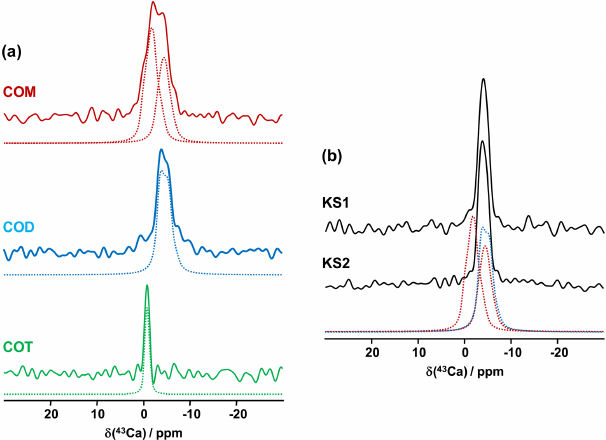
Figure 6. (a) Natural abundance 43 Ca MAS NMR spectra of COM (red), COD (blue) and COT (green) recorded at 20.0T ( ν rot = 3 to 5kHz). The dashed lines correspond to fits. (b) Natural abundance 43 Ca MAS NMR spectra of KS1 and KS2. The red dashed lines cor- respond to the two resonances associated to COM. The blue dashed line corresponds to the 43 Ca MAS NMR spectrum of